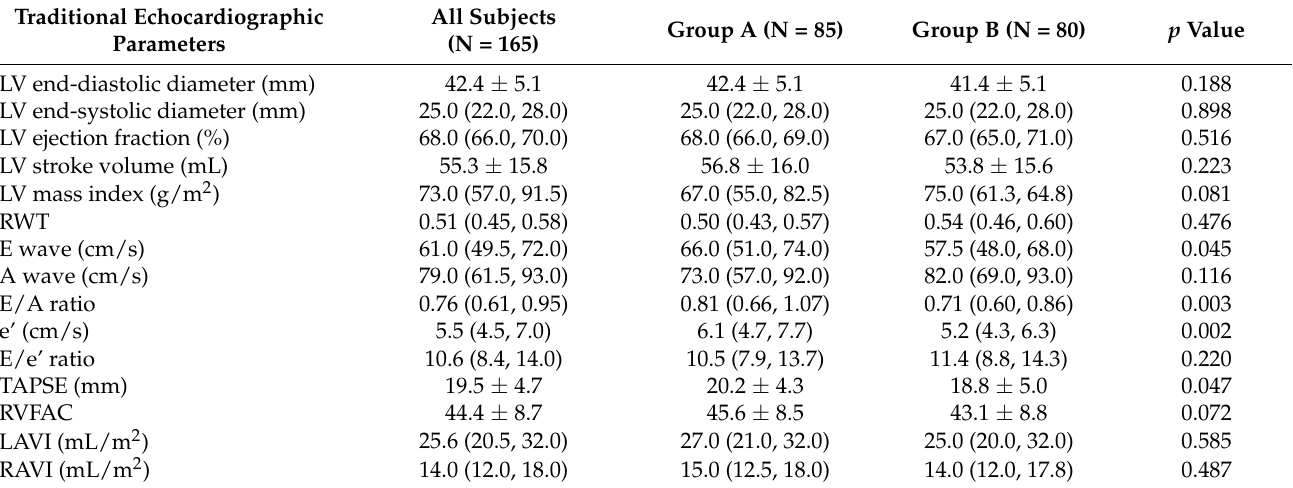
Table 2. Comparison of the traditional echocardiographic parameters according to the CAVI